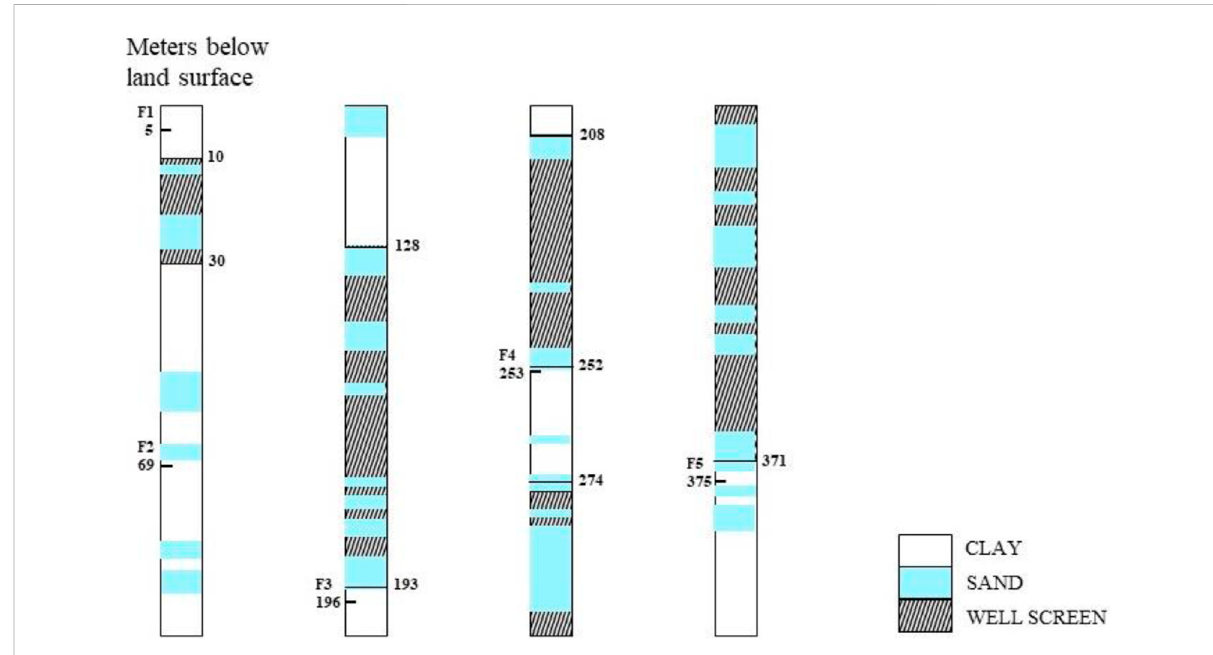
FIGURE 7 Soil pro fi le: the central urban area of Cangzhou. Solid vertical lines indicate the interval of well